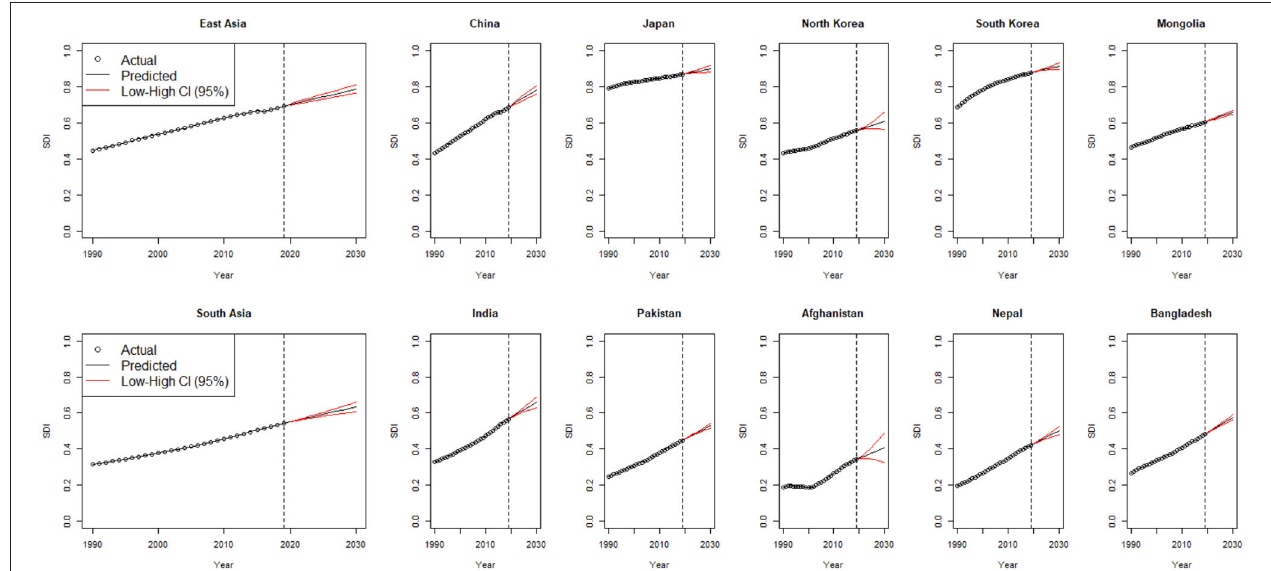
FIGURE 5 | Observed, estimated, and predicted trends in SDI from 1990 to 2030, by region and countries; SDI, sociodemographic index; CI, confidence interval.